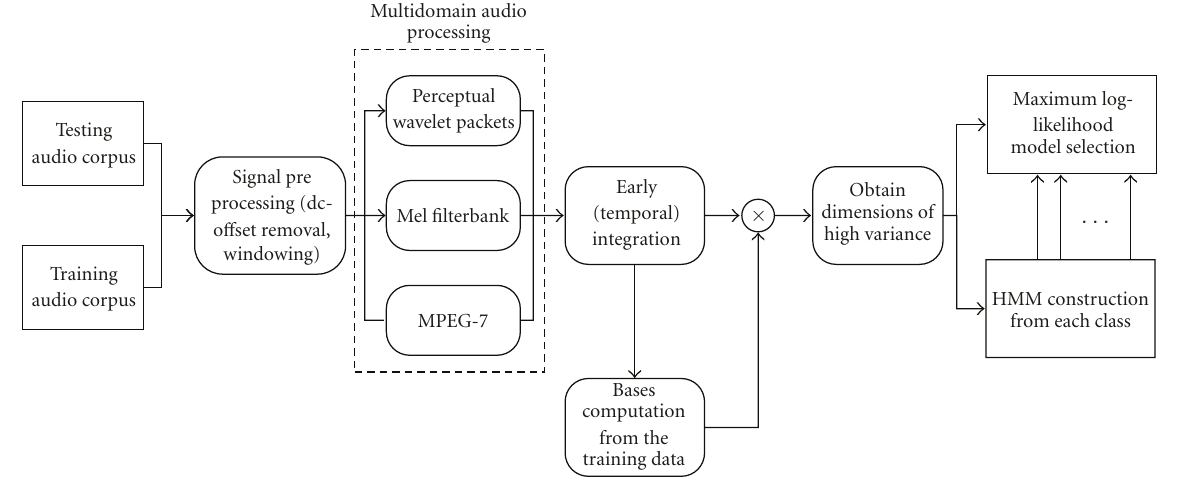
Figure 1: Block diagram of the audio classification